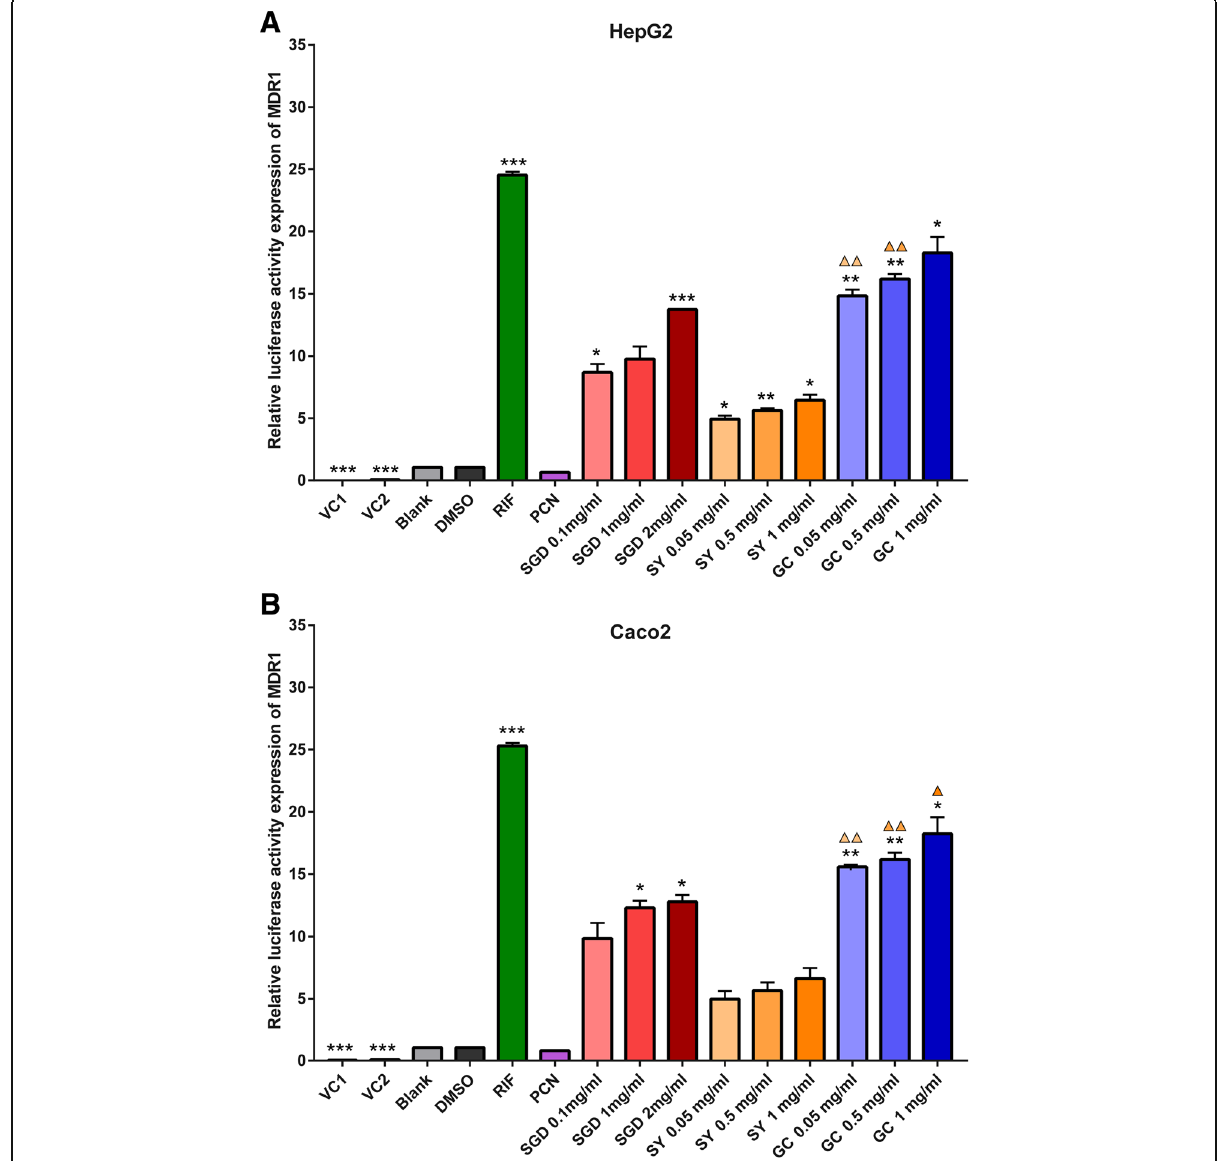
Fig. 4 Induced effects of MDR1 promoter mediated via PXR by SGD, SY and GC in HepG2 ( a ) and Caco2 ( b ). There is a significant increase in positive control RIF group and most prescriptions groups when compared with 0.1% DMSO treatment group ( p < 0.05). There is no significant decrease in negative control PCN group when compared to the DMSO group ( p > 0.05). VC1: cells were transfected with pcDNA3.1-PXR, PRL- SV40, pGL4.17; VC2: cells were transfected with pcDNA3.1, PRL-SV40, pGL4.17-CYP3A4; other groups: cells were transiently transfected with pcDNA3.1-PXR, PRL-SV40, pGL4.17-CYP3A4. All data were obtained from three independent experiments performed by triplicate and expressed as mean ± S.E.M. Statistical significance was determined by one-way ANOVA with Welch correction, followed by the Games Howell test. One-way ANOVA with Welch ’ s correction revealed significant differences among the groups (Welch ’ s p < 0.001). * p < 0.05, ** p < 0.01, *** p < 0.001 compared with the DMSO group; ▲ p < 0.05, ▲▲ p < 0.01 represents GC group compared to SY group with the same